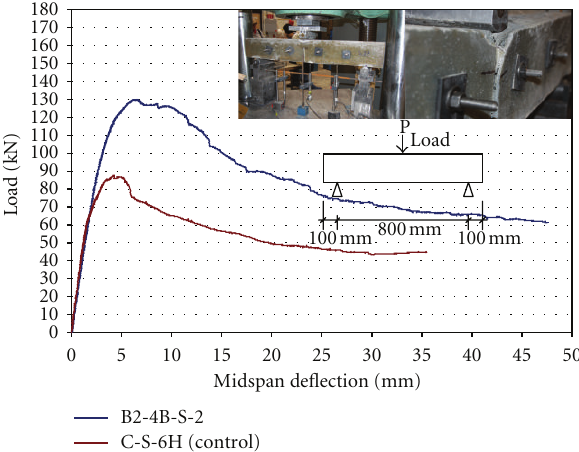
Figure 24: Load versus midspan deflection of RC beam B2-4B-NS- 2.